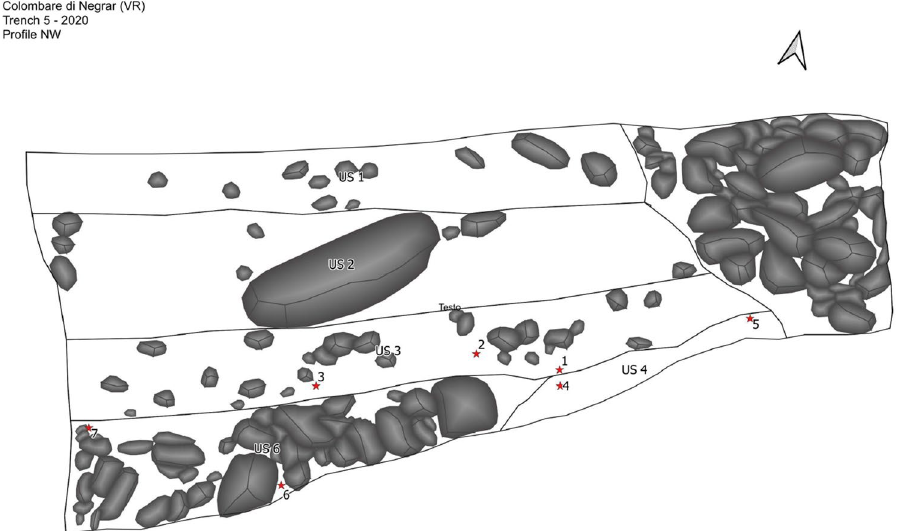
Figure 3. Sediment fractions related to the 7 samples of the 5–2020 trench (US4 (US3): sample 1; US3: sample 2; US4: sample 3; US3: sample 4; US3: sample 5; US6: sample 6; US6: sample